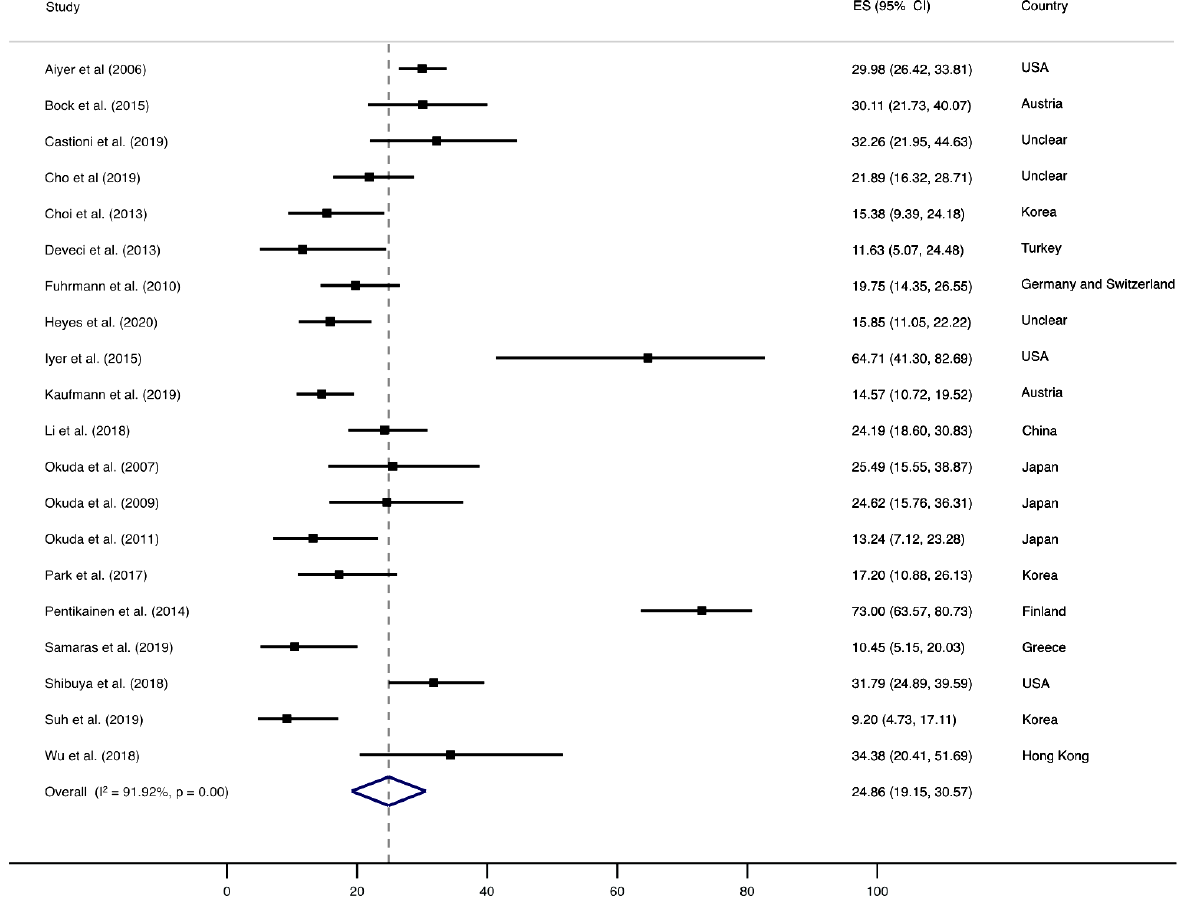
Figure 2. Forest plot showing the pooled prevalence of HV. Squares represent the pooled prevalence for each study, and the diamond represents the overall pooled prevalence.